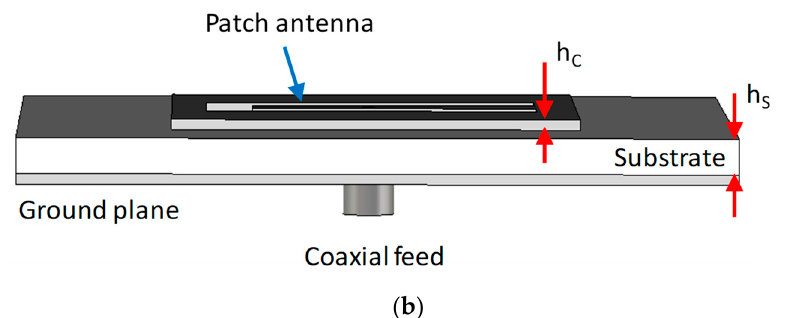
Figure 2. Geometry of the flexible textile antenna with a U-shaped aperture. ( a ) Top view, ( b ) side view.